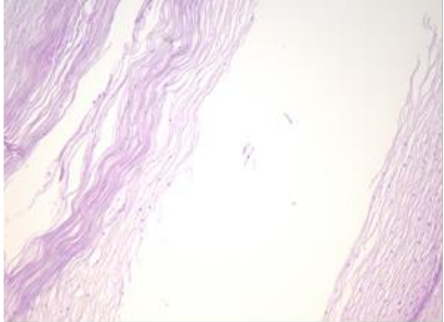
Figure 3. Exo-cervix shows a cystic structure in the deeper layers that is filled with an amorphic, eosinophilic, lamellar substance (HE staining, 5X).